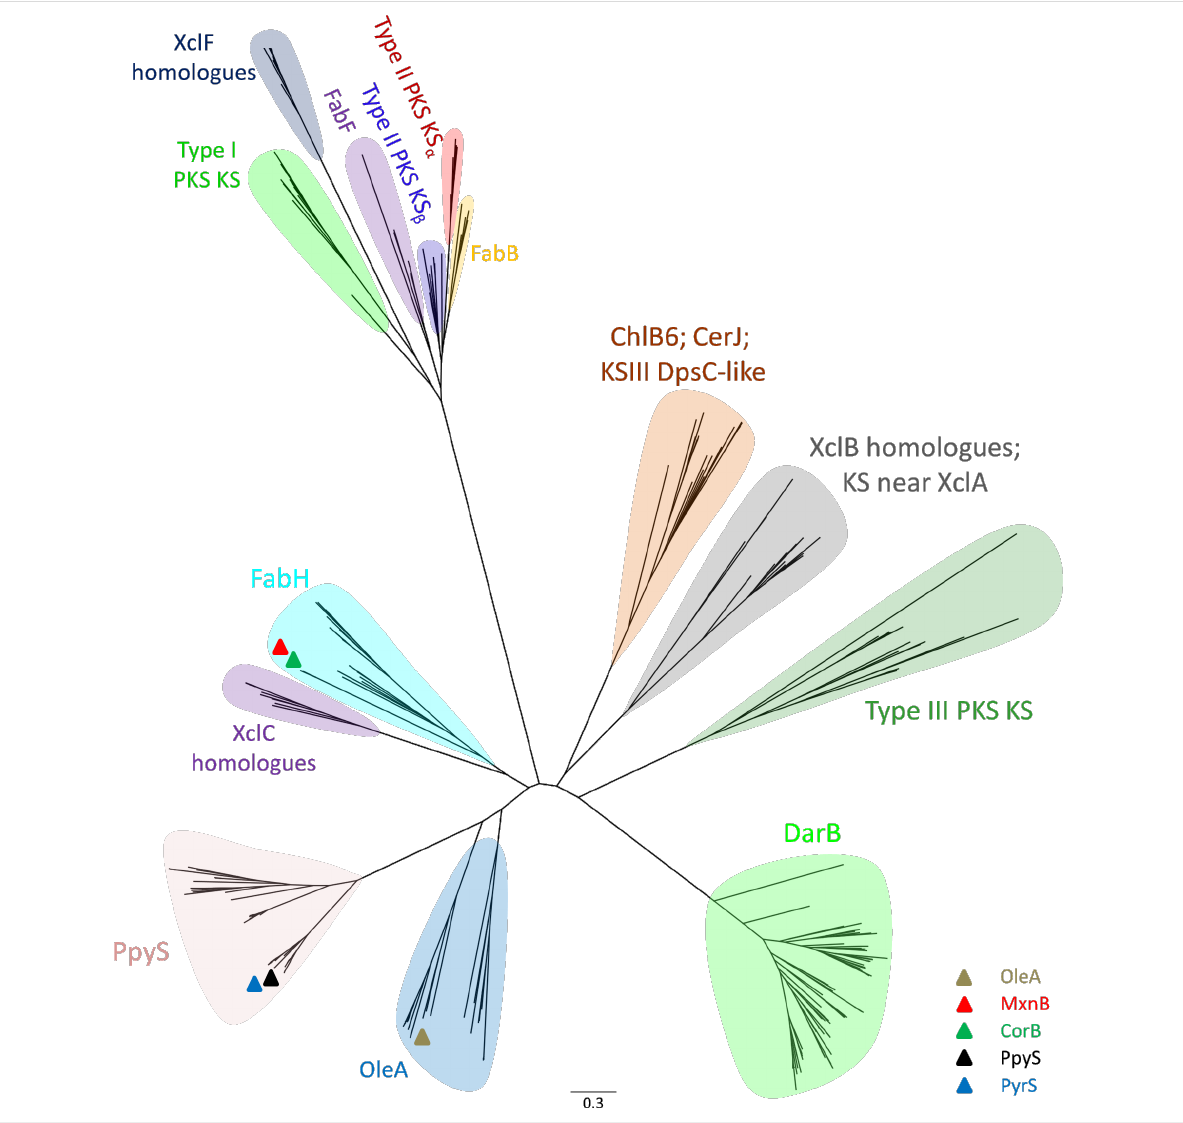
Figure 3: Phylogenetic tree (PHYML) composed of PpyS, its homologues and other known ketosynthases. Table S4 (Supporting Information File 1) lists all shown ketosynthases in this tree. The scale bar indicates the degree of divergence as substitutions per site.